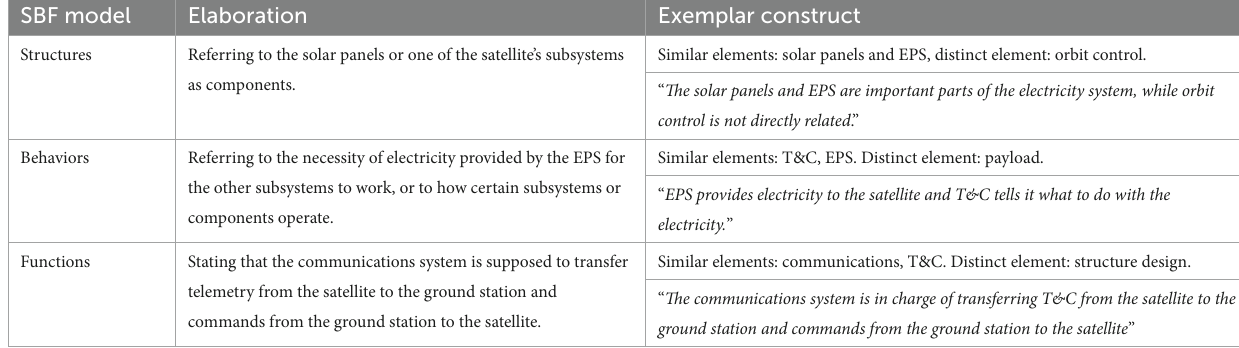
TABLE 4 Examples of how structures, behaviors and functions are displayed in the repertory grid